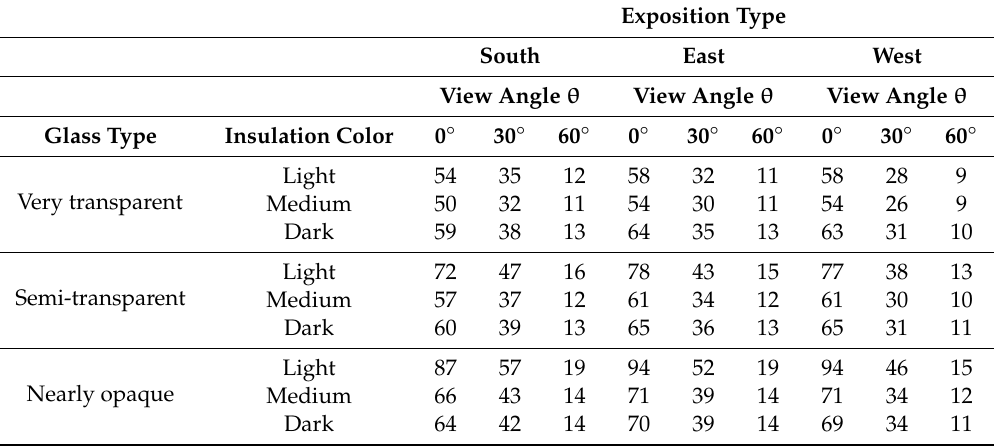
Table 7. Maximum temperature gradients (K) for London.